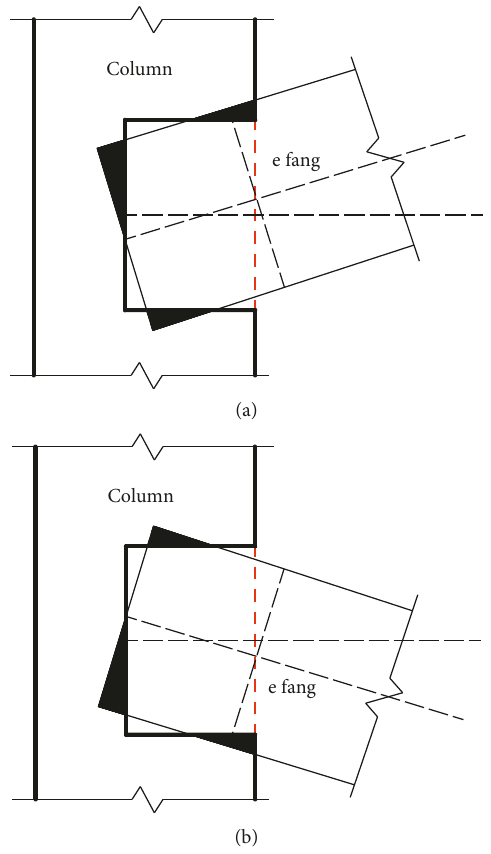
Figure 2: Horizontal displacement loading directions. (a) Upward loading and unloading and (b) downward loading and